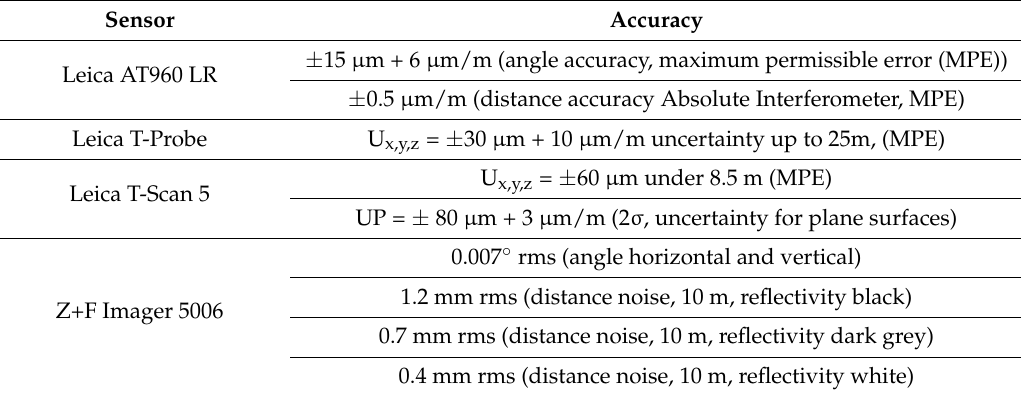
Figure 5. Participating sensors: ( a ) Z+F Imager 5006; ( b ) Leica AT960 LR; ( c ) Leica T-Scan 5 (metrology.leica-geosystems.com); ( d ) Leica T-Probe (www.hexagonmi.com); ( e ) MSS (kinematic-TLS (k-TLS)) consisting of laser scanner Z+F Imager 5006, Leica T-Probe, Leica Absolute Tracker 960 Long Range (AT960 LR). Table 3. Accuracies of the participating sensors (according to manufacturer